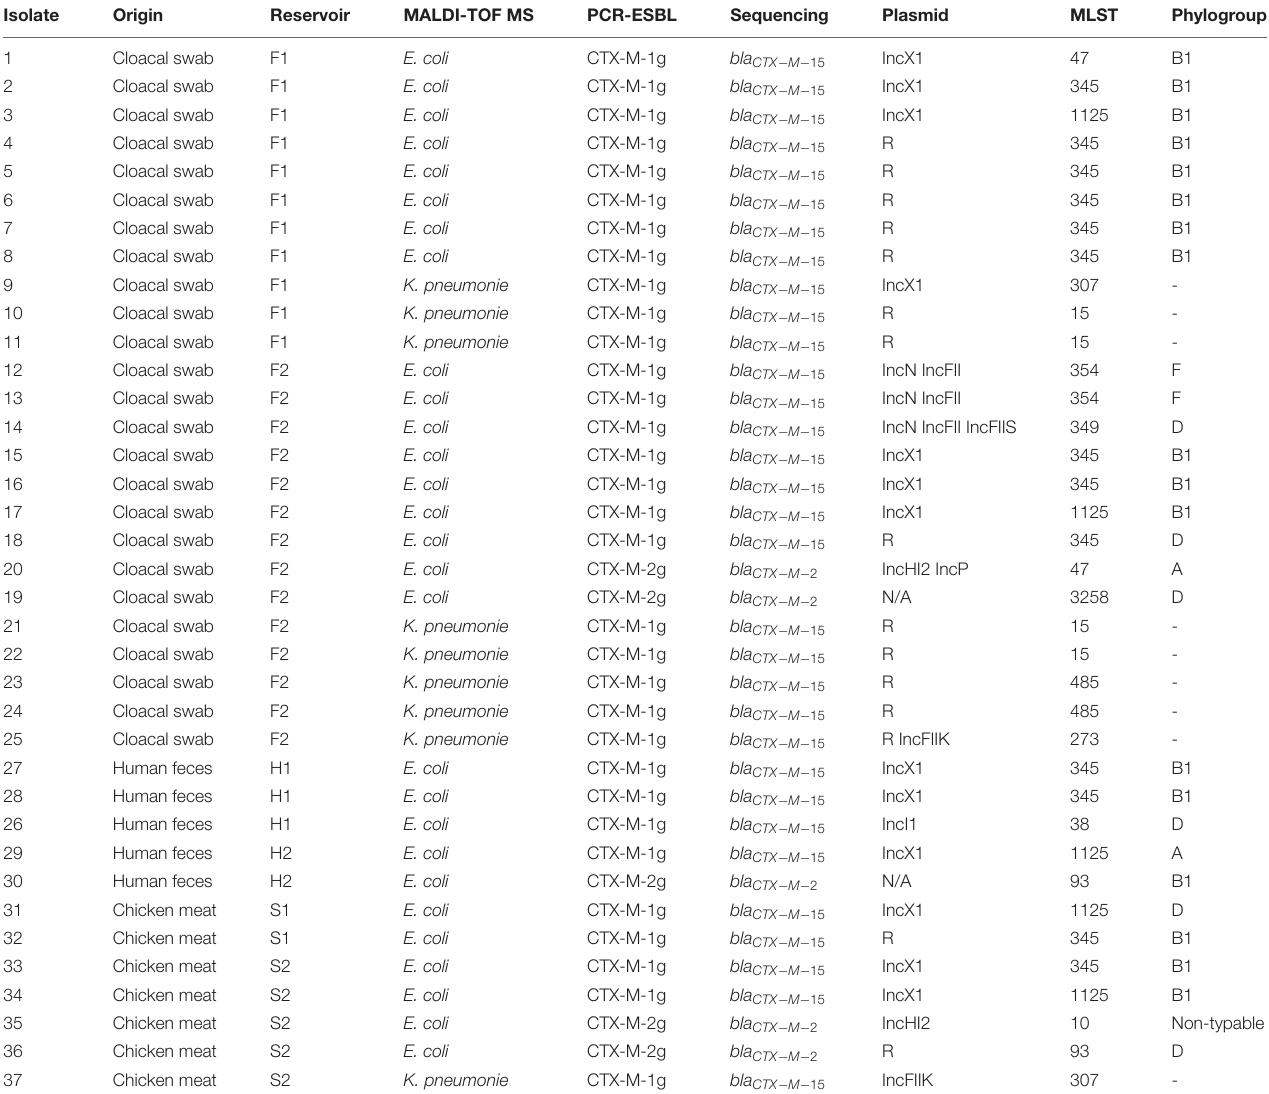
TABLE 1 | Isolate origin, identification, ESBL gene, plasmid type, sequence type, and phylotype.